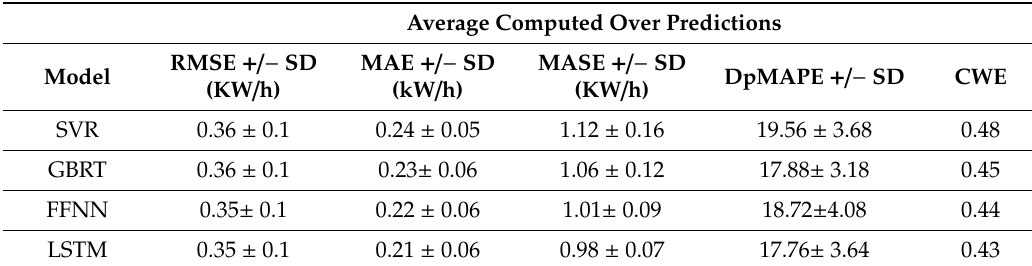
Table 3. Average performance of best variants on 15 test